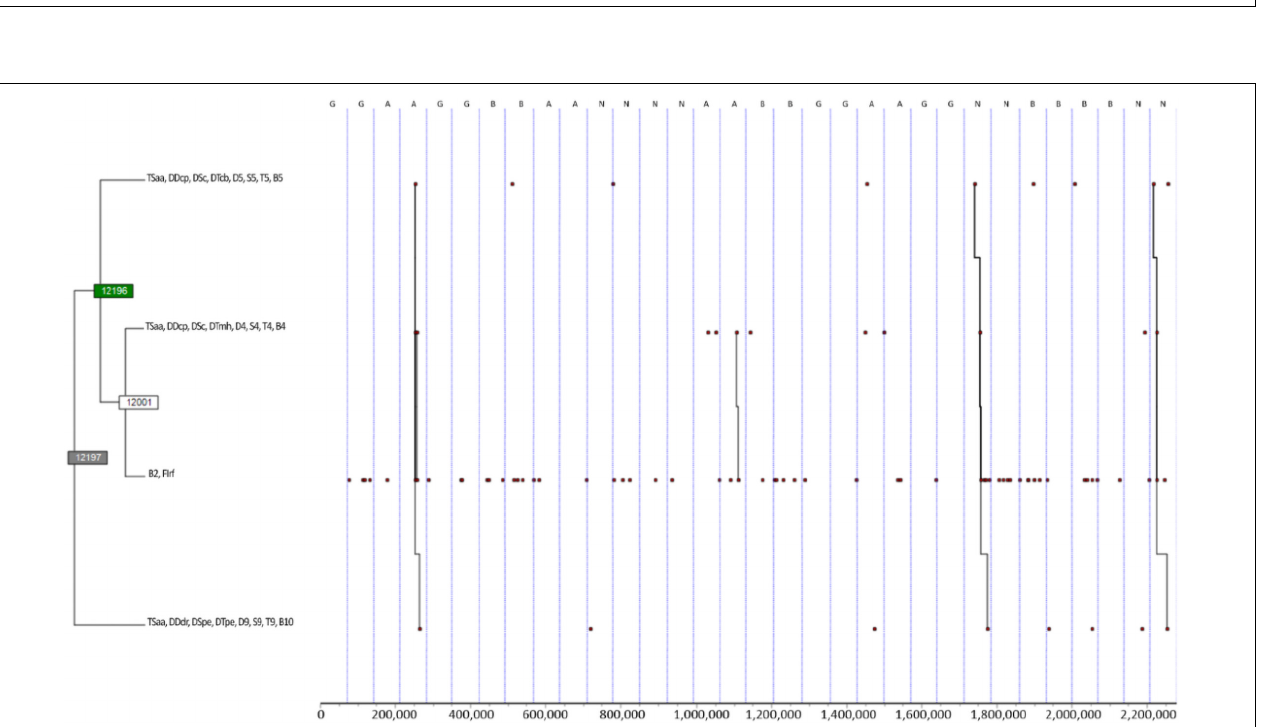
FIGURE 2 | T-pattern detection and analysis of the first, second, and third defender’s tactical–technical actions and field zones, type of subphase, ball field zone, and end of defensive phase, using a lumping factor of 0.90 and minimum occurrence of 3. Pattern: ((TSaa, DDcp, DSc, DTcb, D5, S5, T5, B5 (TSaa, DDcp, DSc, DTmh, D4, S4, T4, B4 B2, FIrf)) TSaa, DDdr, DSpe, DTpe, D9, S9, T9, B10); A, Argentina; B, Brazil; B2, ball in the central strip and ultra-defensive sector field zone; B4, ball in the left strip, defensive sector, and defensive midfield field zone; B5, ball in the central strip and defensive sector field zone; B10, ball in the central strip and offensive sector field zone; D4, first defender in the left strip, defensive sector, and defensive midfield field zone; D5, first defender in the central strip and defensive sector field zone; D9, first defender in the central strip and offensive midfield sector field zone; DDcp, first defender pressure; DDdr, first defender displacements of recovering; DSc, second defender contention; DSpe, second defender control or balance positioning; DTcb, third defender cover; DTmh, third defender player marking; DTpe, third defender control or balance positioning; FIrf, end of defensive phase by shot off goal conceded; G, Germany; N, Netherlands; S4, second defender in the left strip, defensive sector, and defensive midfield field zone; S5, second defender in the central strip and defensive sector field zone; S9, second defender in the central strip and offensive midfield sector field zone; T4, third defender in the left strip, defensive sector, and defensive midfield field zone; T5, third defender in the central strip and defensive sector field zone; T9, third defender in the central strip and offensive midfield sector field zone; TSaa, delay subphase.